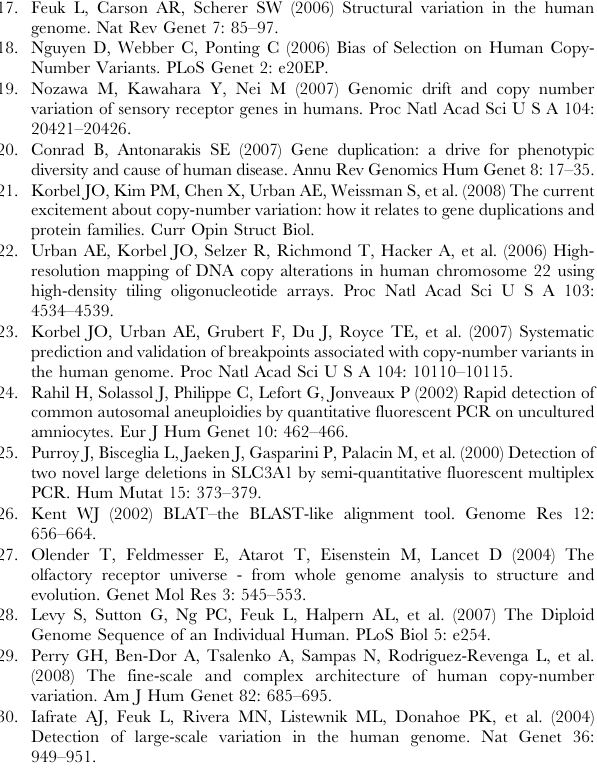
highlighted 100% sequence-identity stretch in the alignment of OR8U8 and OR8U1 at the 5 9 region (bases 472–590). Found at: doi:10.1371/journal.pgen.1000249.s009 (1.35 MB TIF) Figure S10 Correlation of OR copy-number variability with paralog-similarity, but not with OR subfamily size. OR subfamily assignments were based on the HORDE database (http://bip. weizmann.ac.il/HORDE/). Each circle represents an OR sub- family of certain size, as indicated by circle size and color (according to the scale on the right). Numbers in parentheses indicate numbers of subfamilies of a given size, e.g. there are 52 subfamilies with 2 OR members. The largest subfamily with 85 members is subfamily 7E. Average best-hit % identity was calculated as the average of all % identities of each subfamily member with its closest OR. Average subfamily variance was calculated as the average R-based variance of all ORs in a subfamily. (A linear regression fit was calculated for subfamilies with 2 members. Table S1 Normalized qPCR Cp values for 122 OR loci. Quantitative PCR (qPCR) data of 122 ORs, measured in 22 individuals. The qPCR values are normalized relative to the RCAN1 gene. NT: -Not Tested-; DEL: reactions consistently failed in both duplicates (in at least two independent experiments), thus indicating a homozygous deletion of the locus. Table S2 Coordinates and normalized microarray measures R for all OR loci. Mean normalized relative intensities (i.e. the measure R) for 851 OR gene and pseudogene loci, are given as detected using custom high-resolution oligonucleotide tiling microarrays. Genomic coordinates for each locus are indicated.